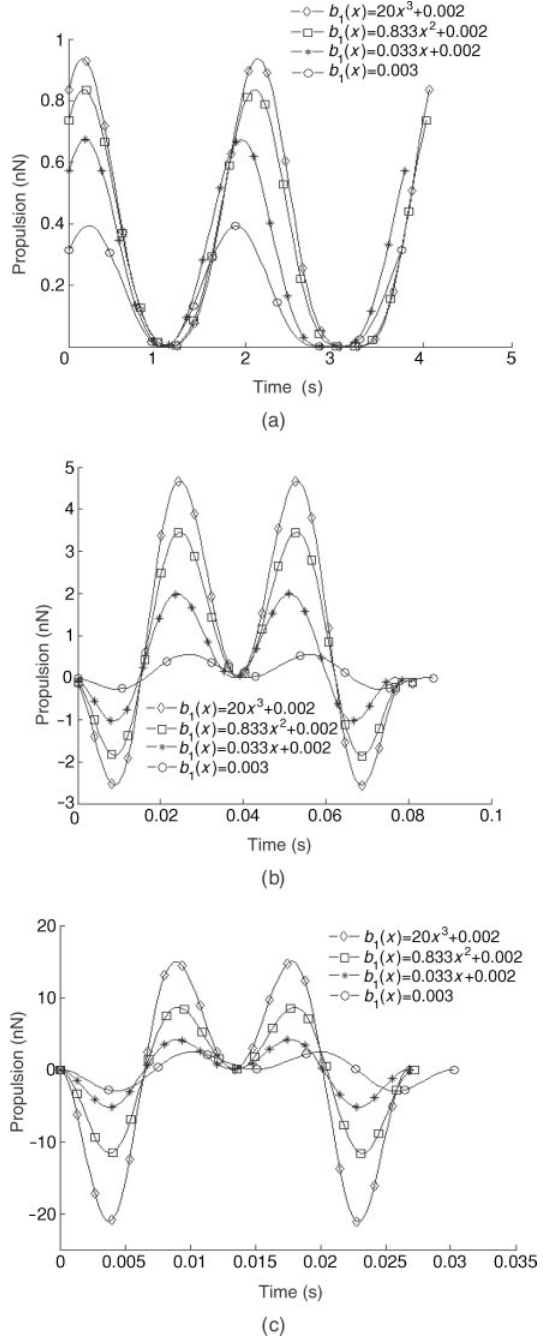
Figure 7 Propulsion of caudal fins in a cycle: (a) the first-stage resonance frequency; (b) the second-stage resonance frequency; and (c) the third-stage resonance